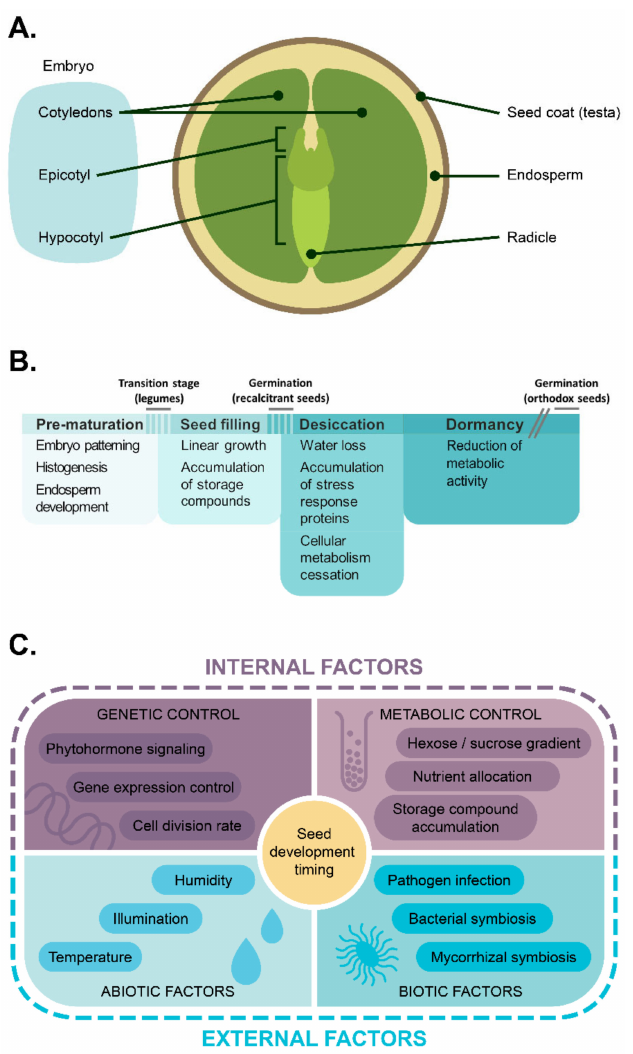
Figure 1. An overview of legume seed anatomy and maturation mechanisms. ( A ) Simplified anatomy of legume seed. ( B ) Timeline of seed development. The overlaps between stage bars reflect the coincidence of several processes intrinsic for different stages in some plants, e.g., family Brassicaceae. The break in the bar denoting the dormancy stage refers to the (potentially) unlimited duration of dormancy in desiccated orthodox seeds. ( C ) Key regulators of seed development and dormancy reviewed in this